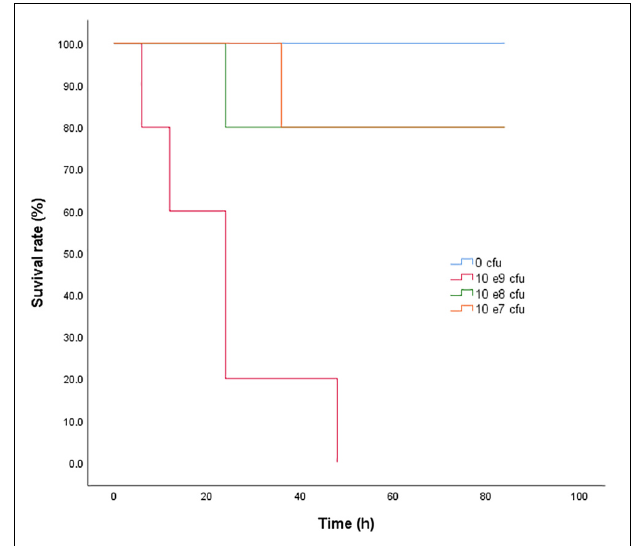
FIGURE 2 | The survival rate of rabbits 84 h after the last bacterial inoculation.